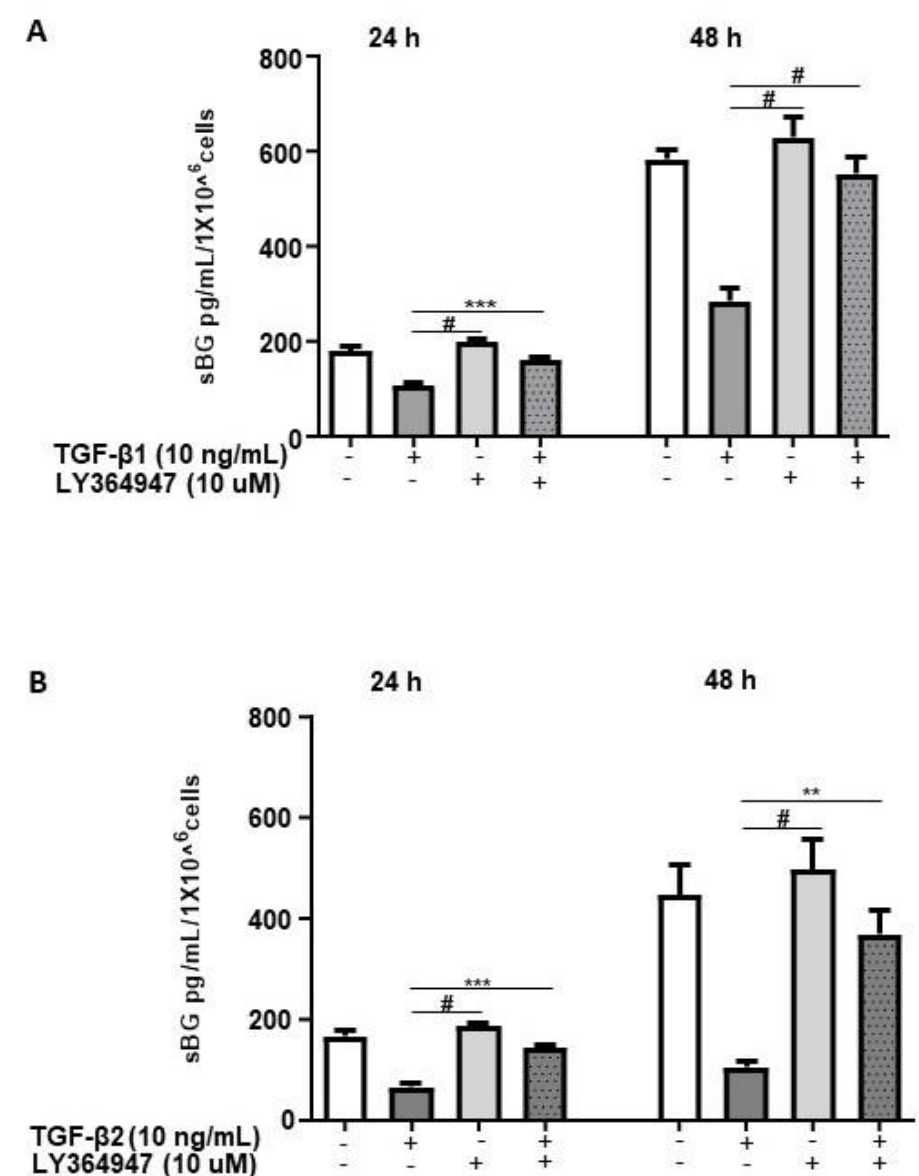
Figure 2. TGF- β 1/2-mediated reduction in BG shedding is TGF- β type 1 receptor (ALK-5)-dependent. Figure 2. TGF- β1/2 -mediated reduction in BG shedding is TGF- β type 1 receptor Epithelial 12Z cells were pre-incubated in the absence or presence of ALK-5 inhibitor, LY364947 (ALK-5)-dependent. Epithelial 12Z cells were pre-incubated in the absence or presence of ALK-5 (10 µ M) for 2 h prior to stimulation with TGF- β 1 (10 ng/mL) ( A ) or TGF- β 2 (10 ng/mL) ( B ) for 24 and 48 h; supernatants were analyzed by sBG ELISA. LY364947 significantly abrogated the reduction in BG shedding induced by TGF- β 1 and - β 2. Each bar represents the mean ± SEM of three independent experiments performed in duplicate. ** p < 0.01; *** p < 0.001; # p < 0.0001; sBG, soluble